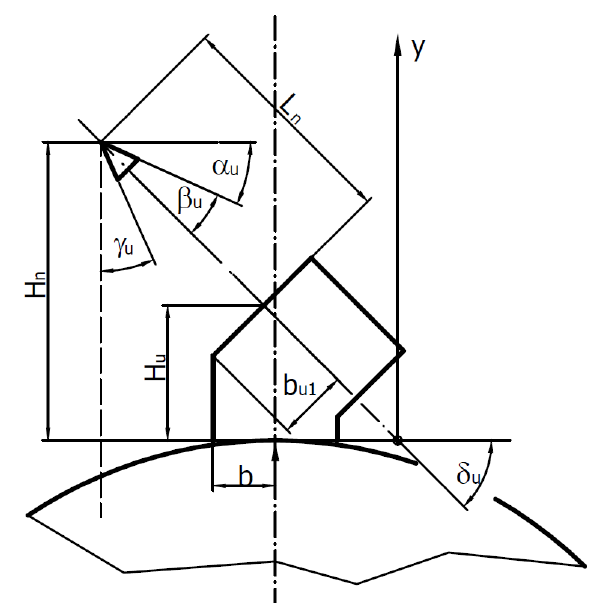
Figure 11. Diagram of the pick and holder on the cutting head.